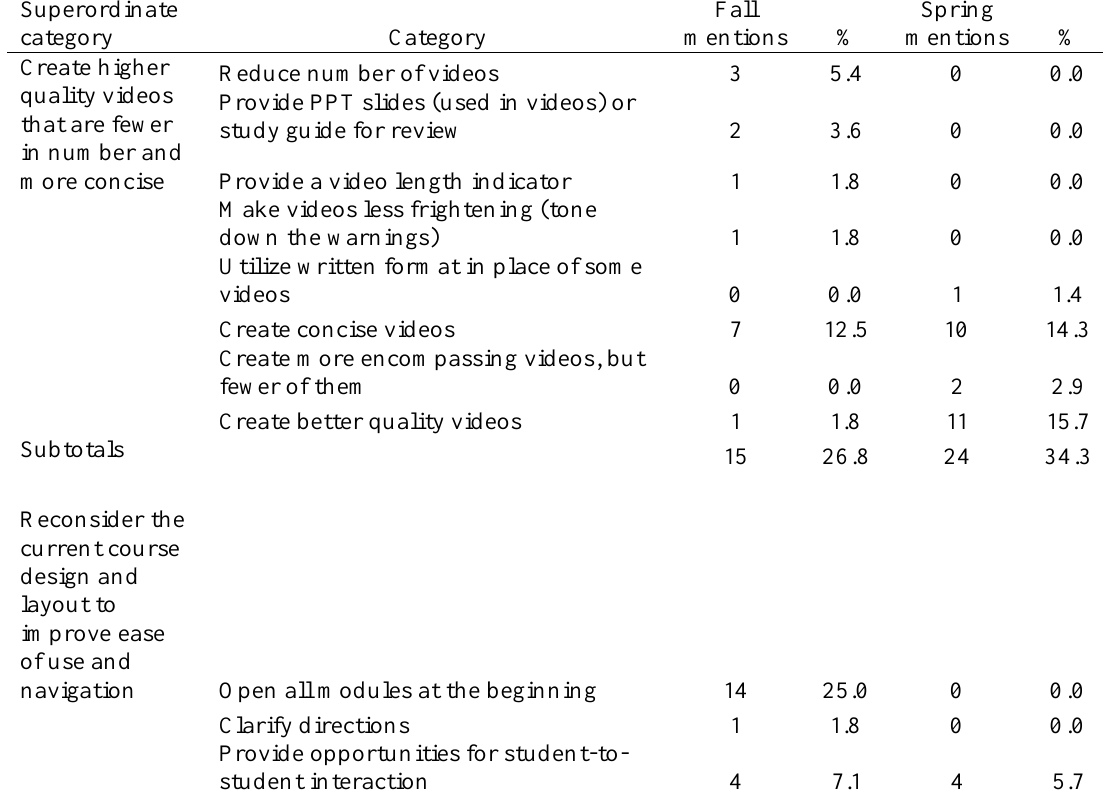
Number of Mentions and Percentages of Categories for Item 3: Suggestions to Improve the Internship Orientation